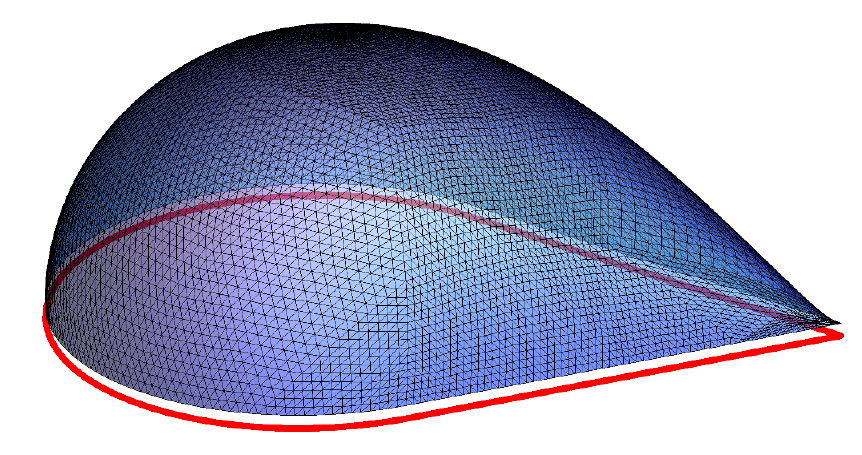
Figure 3 . Triangulated surface in H 3 which approximates the minimal area surface ^ (cid:13) A correspond- ing to a single drop region A in the z = 0 plane, as discussed in section 3.1. The boundary @A (red curve) lies in the z = 0 plane and it is characterised by L = 1 and (cid:18) = (cid:25)= 3. The UV cuto(cid:11) is " = 0 : 03. The triangulation has been obtained with Surface Evolver by setting @A at z = "